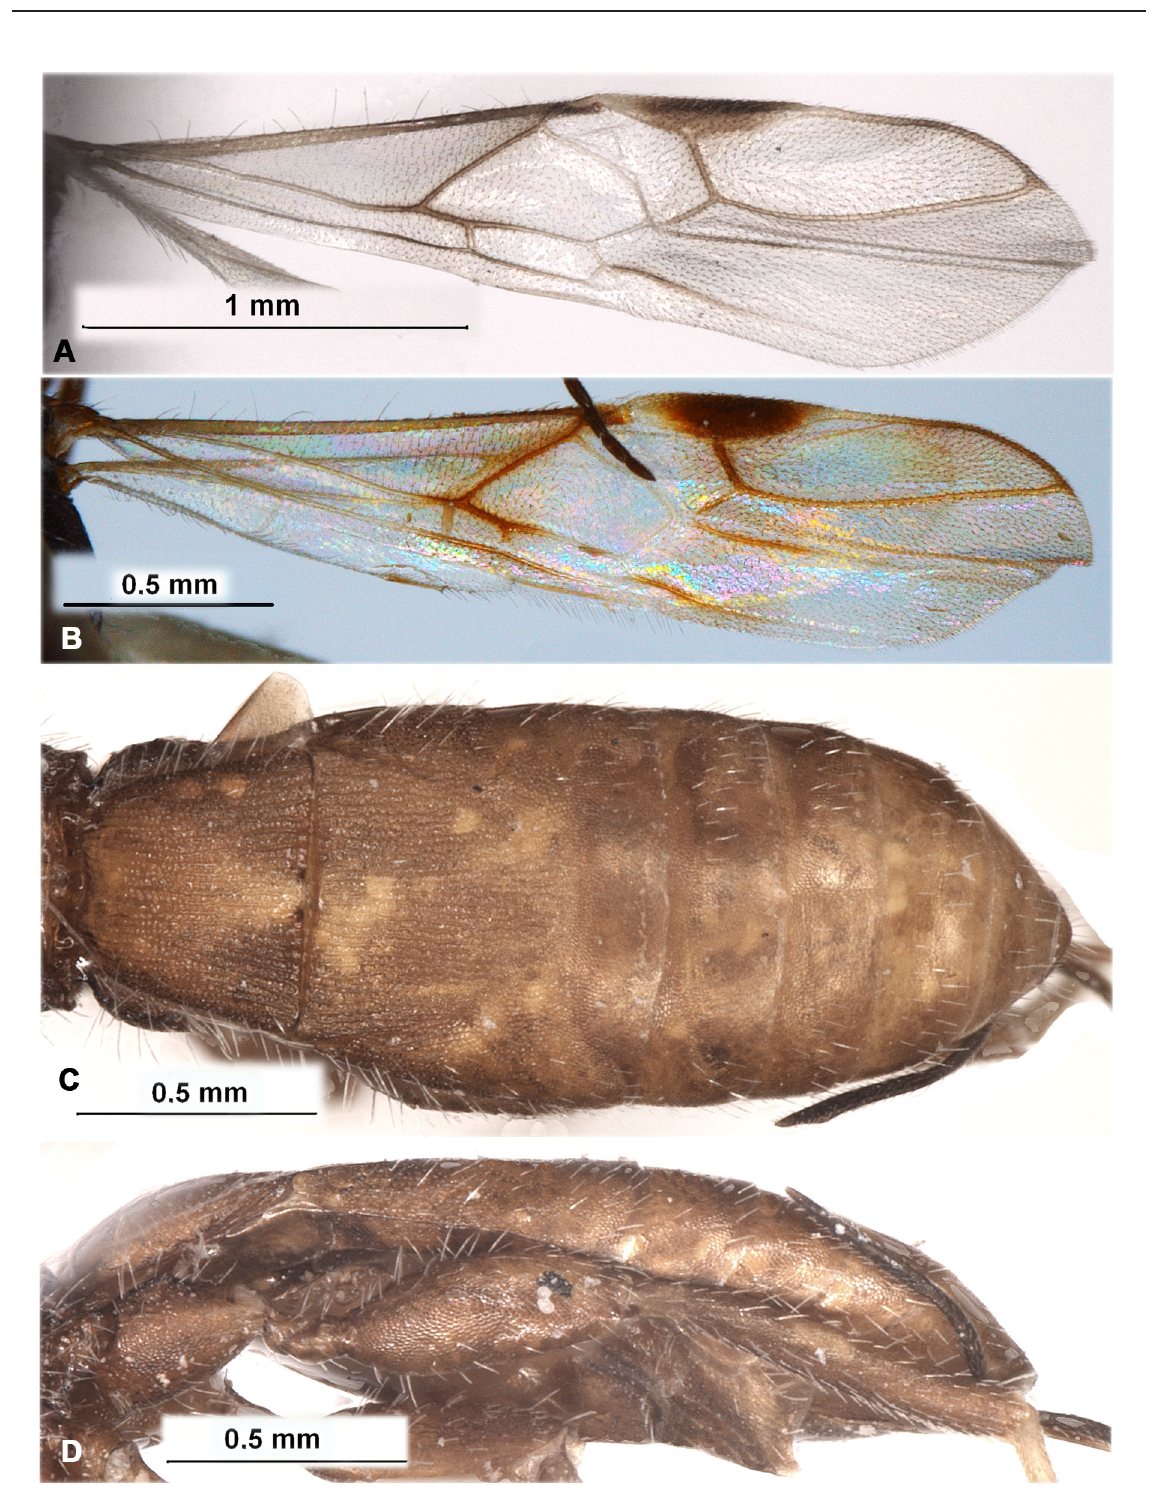
Fig. 13. Mimodoryctes proprius Belokobylskij, 2001. A , C–D . Holotype, ♀ (MNBG). B . Arabian specimen (RMNH). A . Fore wing. B . Fore and hind wings. C . Metasoma, dorsal view. D . Metasoma, lateral